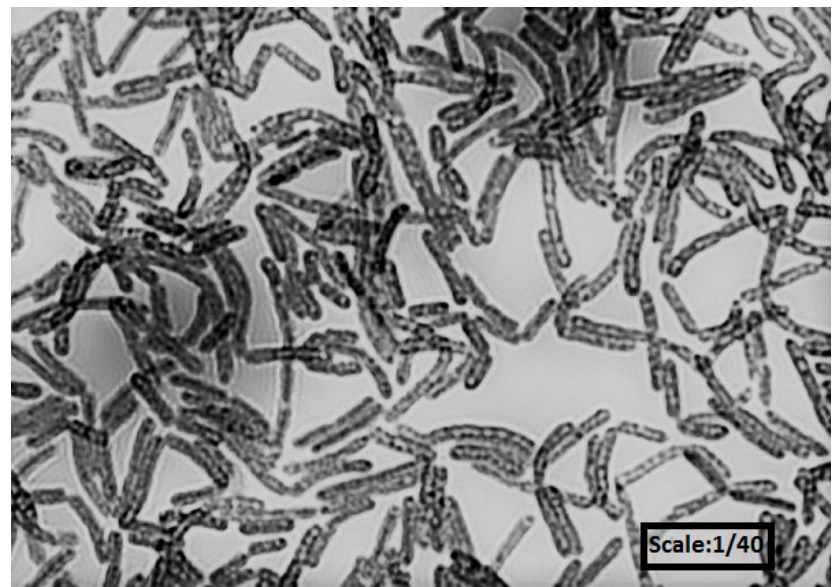
Figure 3. Olympus U ‐ pot microscope picture of the microbial inoculum at 40X magnification. Figure 3. Olympus U-pot microscope picture of the microbial inoculum at 40 × magnification.